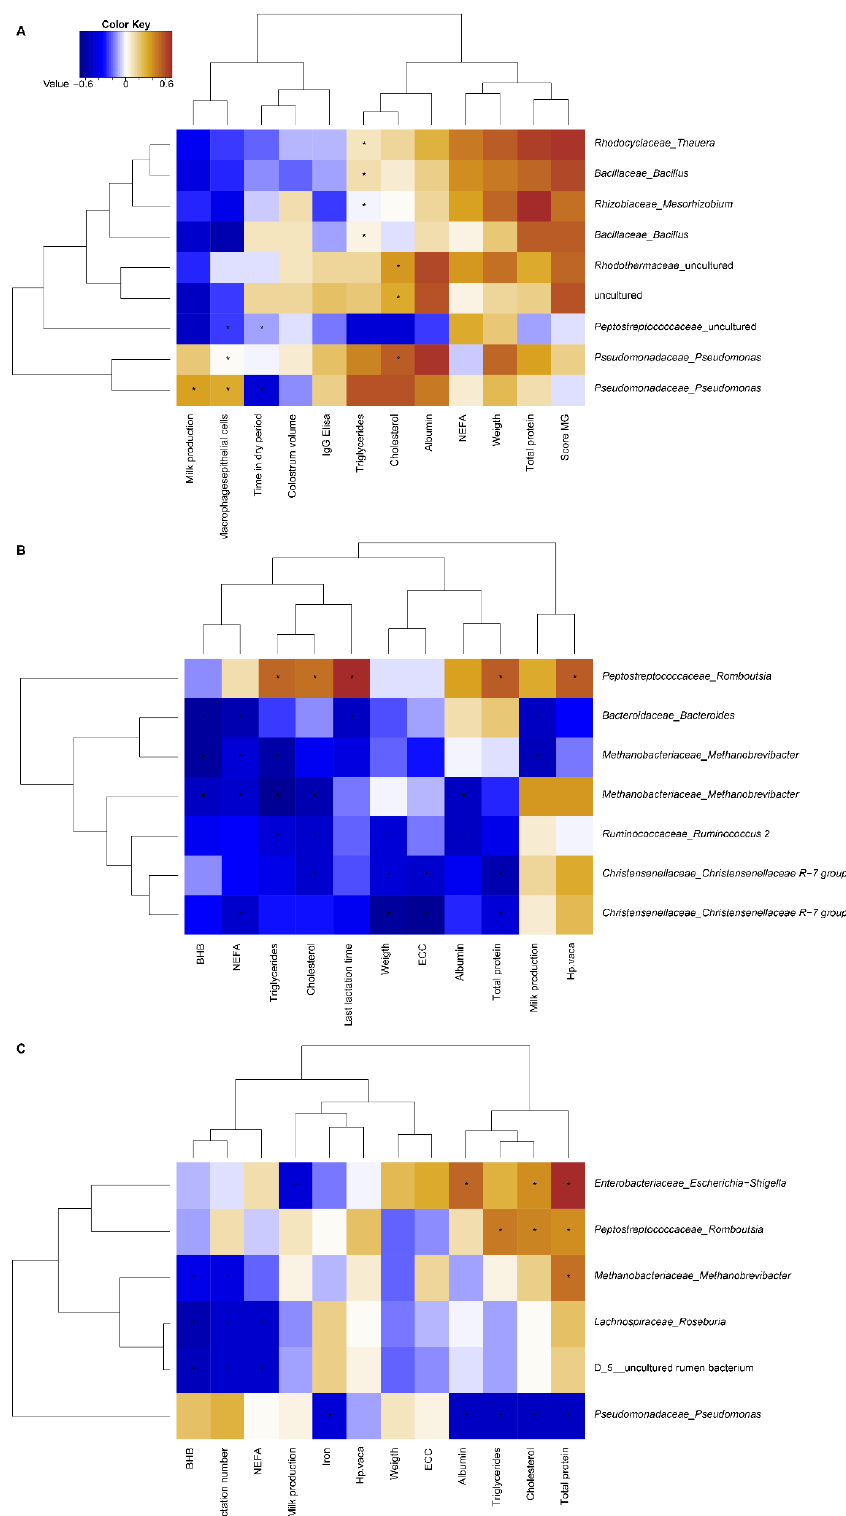
Figure 4. A display of the Spearman correlation between microbiome bacteria and the group of health variables collected. The correlations between ( A ) colostrum bacteria; ( B ) vaginal bacteria; and ( C ) vaginal bacteria against the health variables are indicated by colors (brown: positive; blue: negative). Significant correlations ( p ≤ 0.05) are indicated by *; only the specific health variables that had at least one significant correlation with bacteria are shown in these